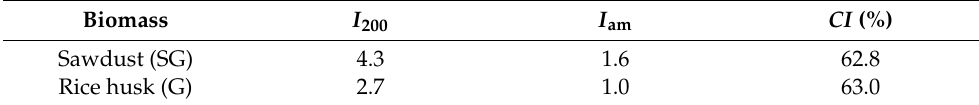
Table 2. Crystallinity index of cellulose. Biomass I 200 I am CI (%) Sawdust (SG)